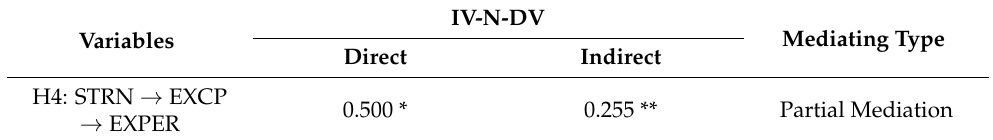
Table 6. Mediating effect